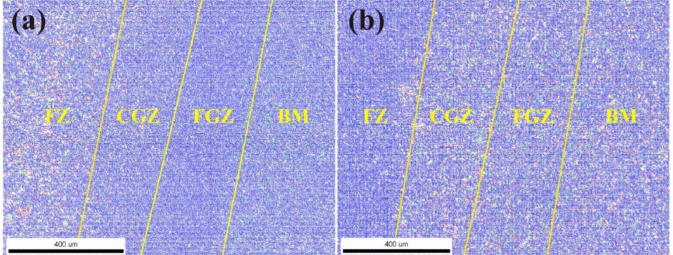
Figure 18. Distribution of angle misorientation of grain boundary ( a ) before quenching; ( b ) after quenching.